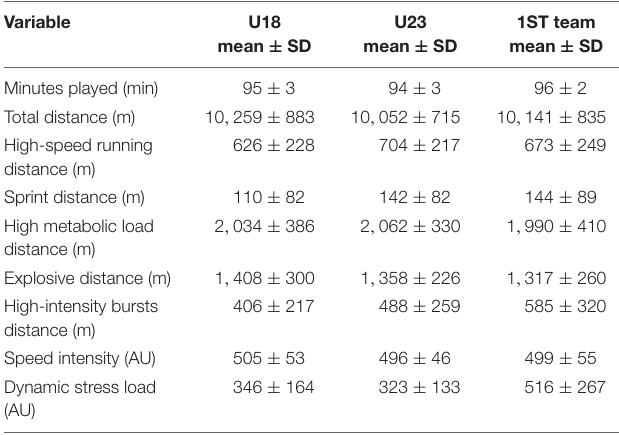
TABLE 1 | Summary of the U18, U23, and 1ST teams’ match